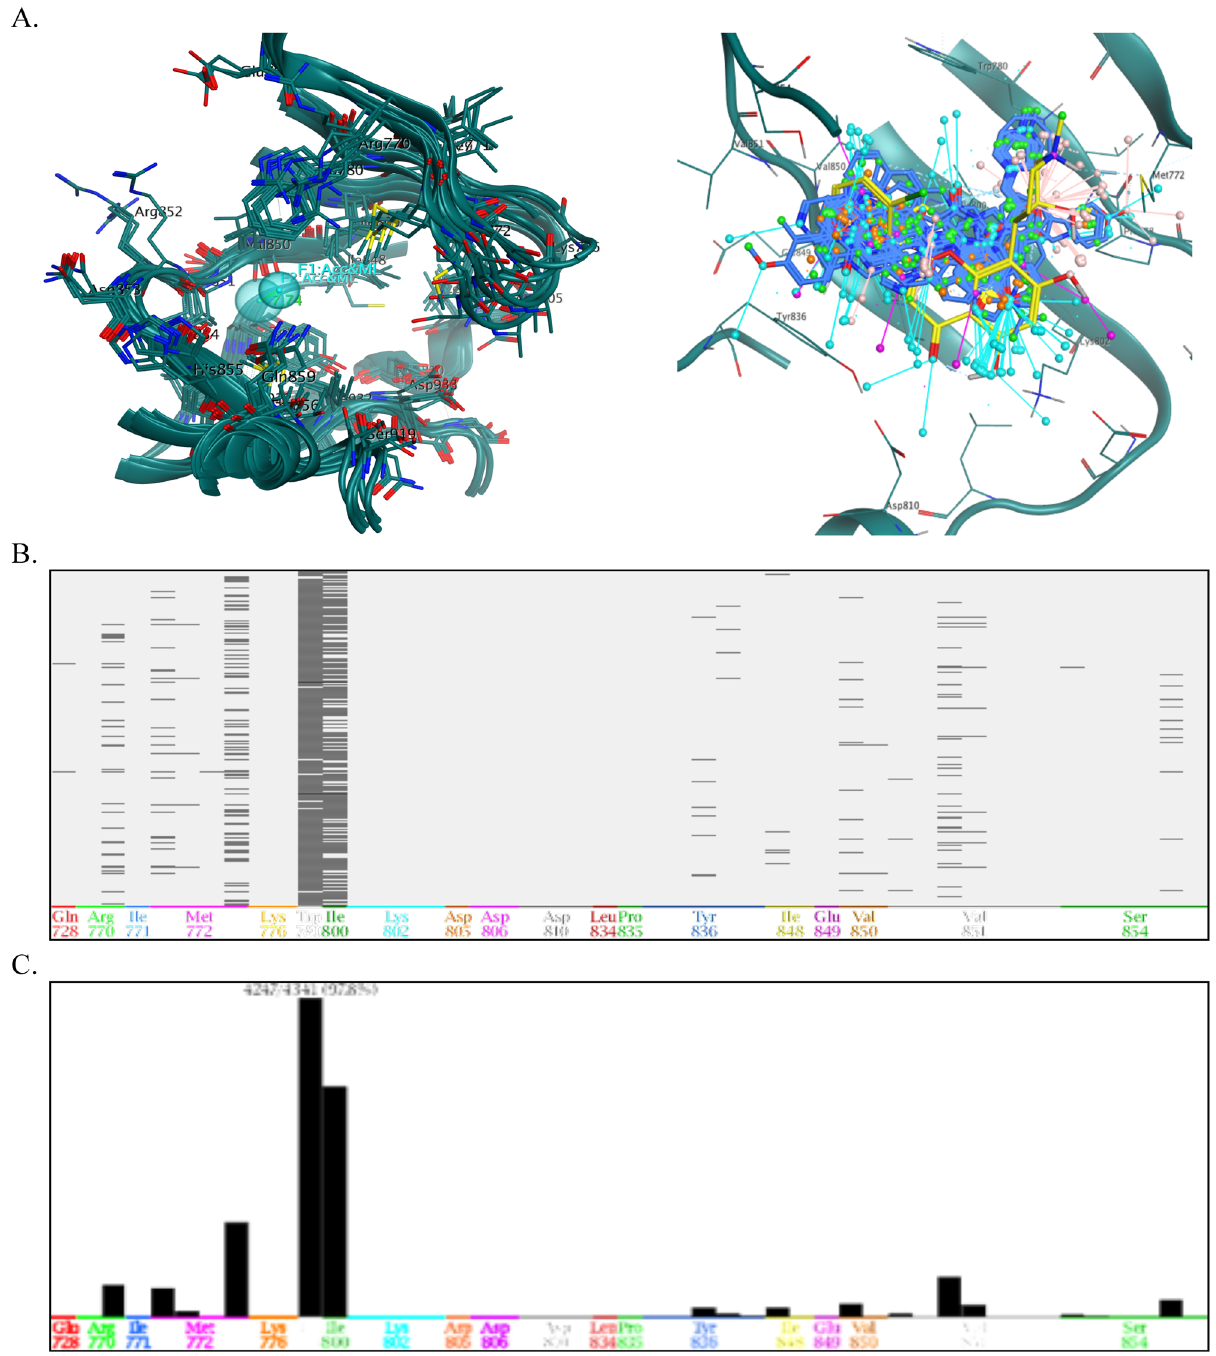
Figure 5. . (A) The distance constraints of vital 3D pharmacophoric features were calculated and displayed in the ATP binding site of PI3K-α and Overlays of virtual hits in the ATP binding site of PI3K-α including vector projections. The PLIF computed the interactions between the PI3Kα-virtual, (B) the barcode representation of fingerprint of the PI3K-α-ligand complexes: The x-axis displays a three-letter code of the key residues and the y-axis shows the number of PI3K-α ligand complexes, and (C) population mode refers to the histogram of fingerprint of the virtual hits showing the number of ligands with which each residue